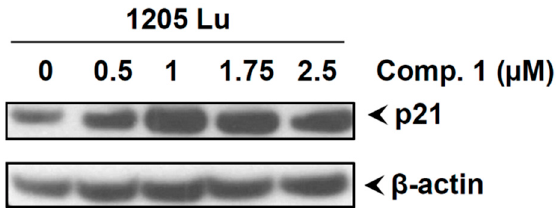
Figure 6. Compound 1 induced p21 expression. After 24 h of treatment with either compound 1 or DMSO (control), 1205Lu cells were collected, and the expression of p21 was analyzed by western blot analysis. ß-actin was used as a loading control.